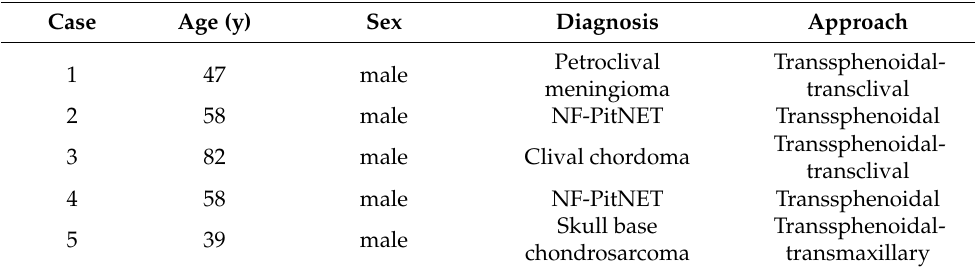
Table 1. Clinical characteristics of